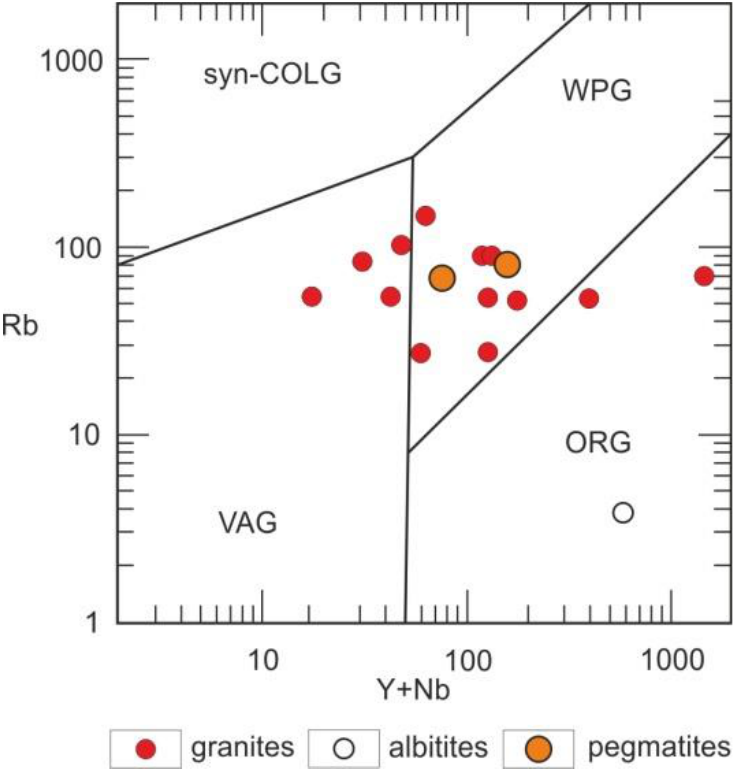
Figure 15. Rb vs. (Y + Nb) diagram for rocks of the Somnitelnyi massif and Tommot deposit. Fields of granitoids: VAG — volcanic arcs, ORG — oceanic ridges, WPG — within-plate, syn-COLG — syncollisional [61].